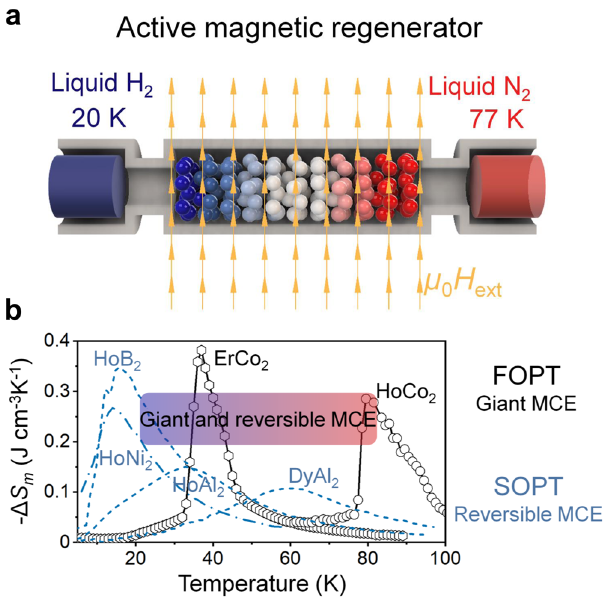
Fig. 1 Magnetic refrigeration materials required for hydrogen liquefaction using magnetic refrigeration. a Schematic of the active magnetic regenerator for hydrogen liquefaction. A series of magnetic refrigerants with tailored transition temperatures at external fi eld ( µ 0 H ext ) are required to cover the large temperature range from the boiling temperature of nitrogen (77 K) to the boiling temperature of hydrogen (20 K). b Isothermal magnetic entropy change ( − Δ S m ) as a function of temperature. Second- order magnetic phase transition materials illustrated by dashed blue curves, for example, HoB 2 20 , HoNi 2 24 , HoAl 2 28 , and DyAl 2 28 show no hysteresis, a giant MCE only at temperatures below 20 K and small MCE at temperatures above 30 K. First-order magnetic phase transition materials indicated by black curves with symbols exhibit giant magnetocaloric effects (MCEs) (large − Δ S m ) at a broad temperature range but with thermal hysteresis near the transition temperature, resulting in irreversible giant MCEs. Therefore, giant and reversible MCEs with broad operating temperature window illustrated by gradient colour from red to blue corresponding to the magnetic refrigerants with different transition in (a) from 77 K to 20 K are desirable for active magnetic